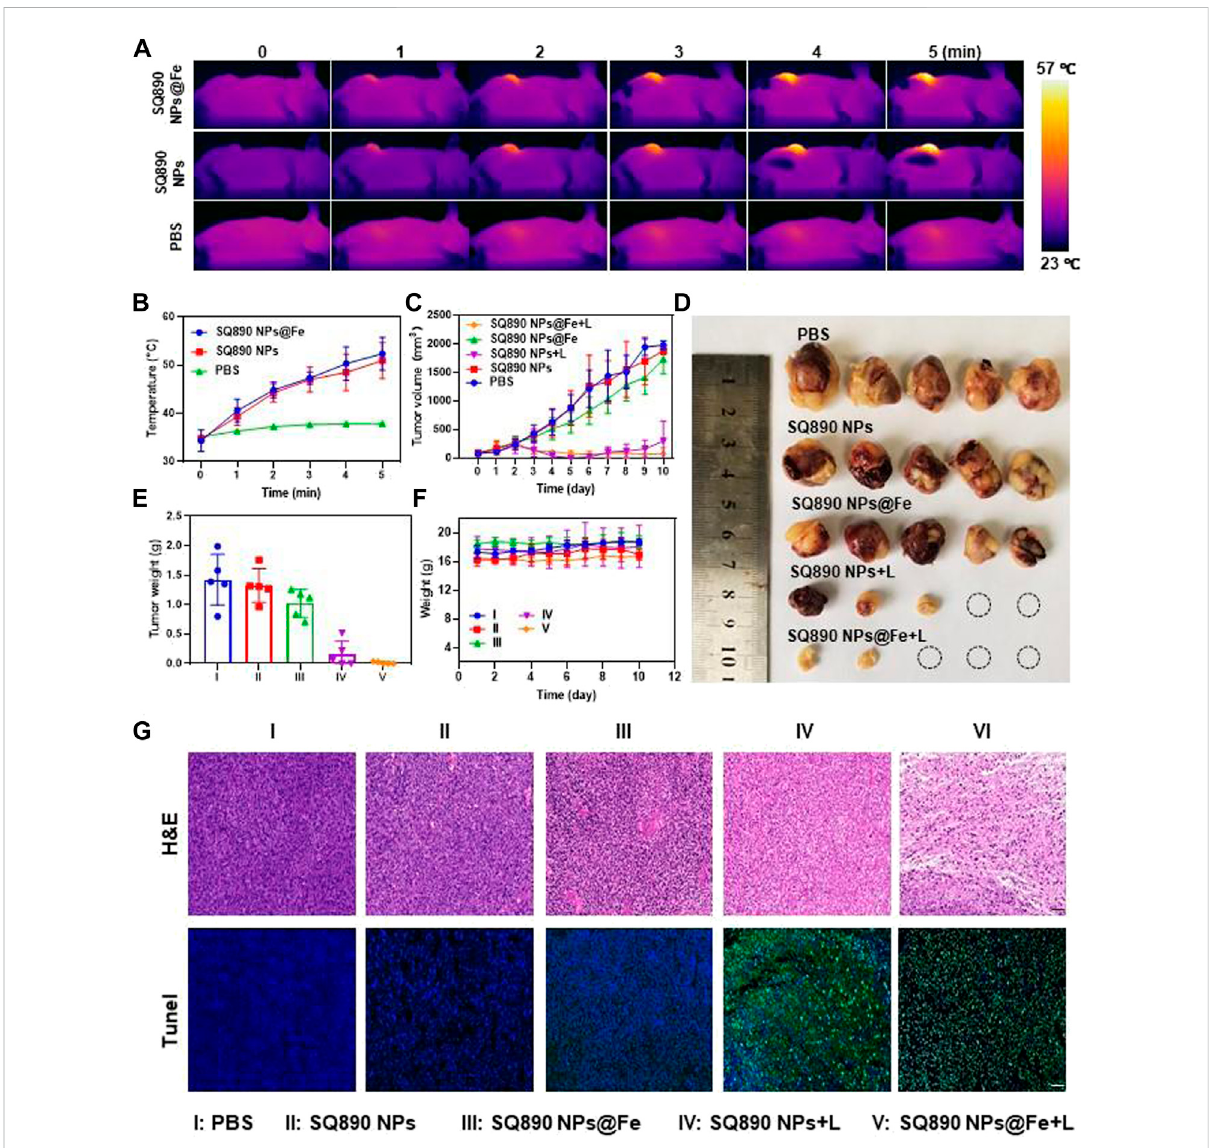
InVivo antitumoreffects. (A,B) IRthermographicpictures (A) andtemperaturechangesofmice (B) administratedwithPBS,SQ890@FeNPs,and SQ890 NPs exposed to 808 nm laser (1 W cm − 2 ). (C) Tumor volume growth curves of mice during the 10-days treatments (* p < 0.05, *** p